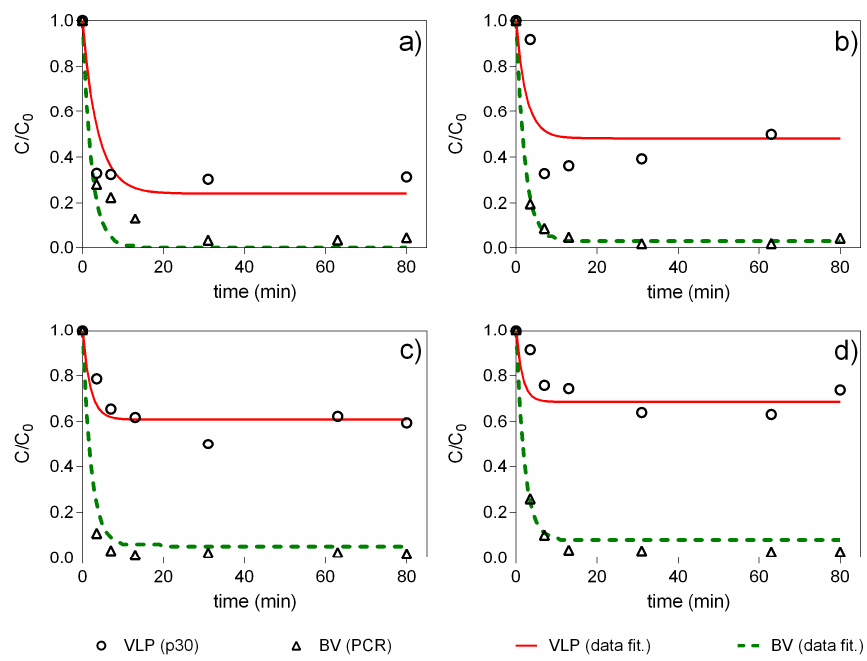
C feedstock ; ( b ) C 0 = 4 = 51.5 ng mL − 1 ; C BV = 2.3 × feedstock feedstock